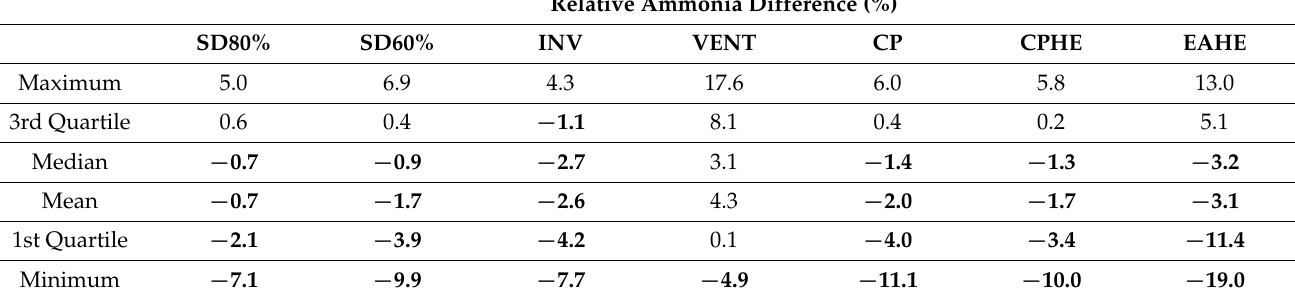
Table 1. Descriptive statistics (maximum, 3rd quartile, median, mean, 1st quartile and minimum) of the relative modification of the NH 3 emission MOD (%) between the reference building REF and the application of the seven AMs (stocking density SD80%, stocking density SD60%, inversion of the resting and activity periods INV, doubling the ventilation rate VENT, cooling pads CP, cooling pads and heat exchanger CPHE, and earth-air heat exchanger EAHE). A reduction of the ammonia release is highlighted in